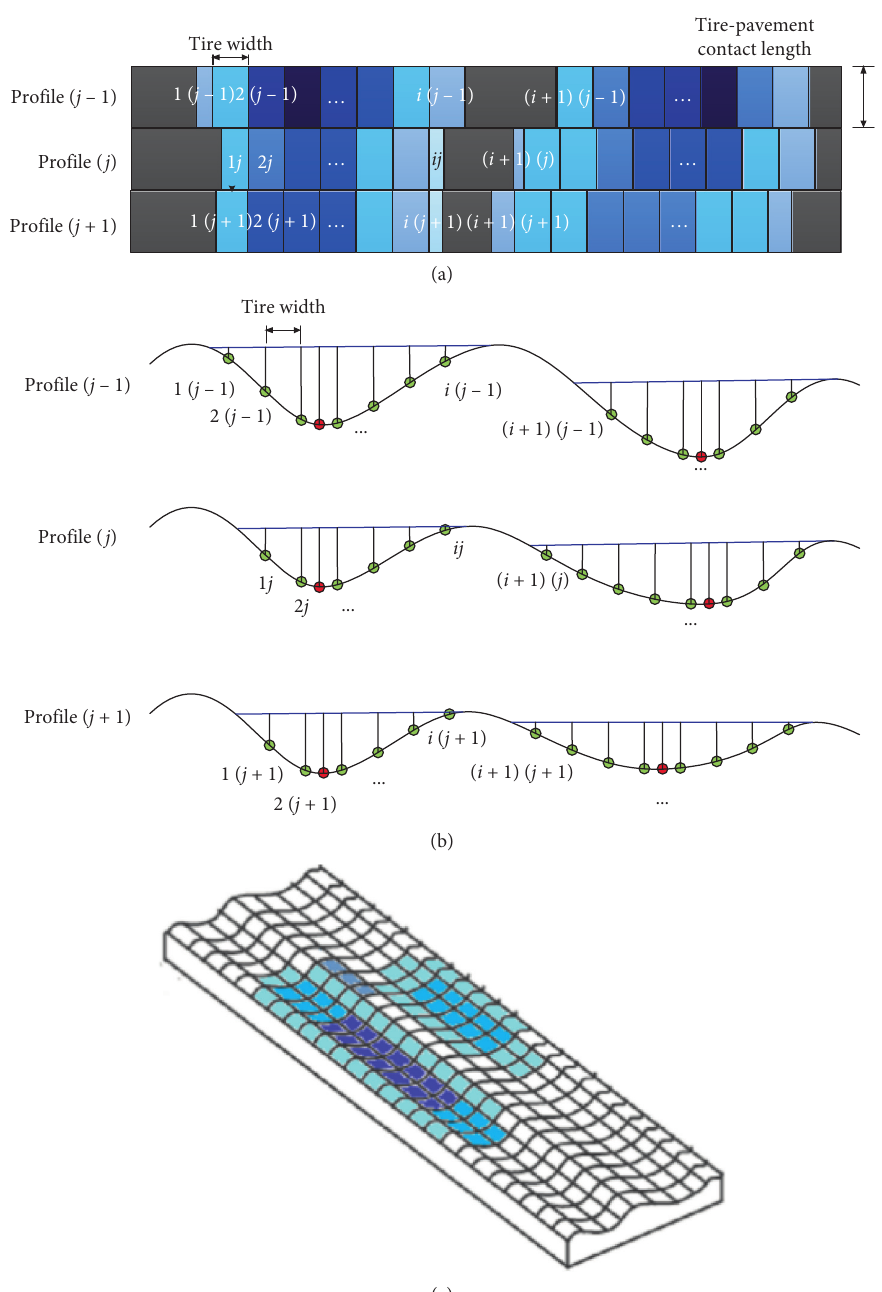
Figure 5: Grid-based water depth distribution. (a) Division of the water accumulation area based on the tire-road contact area. (b) Adjacent rut profile with maximum water depth in each grid (transverse direction). (c) Grid distribution of the water area under the 3D